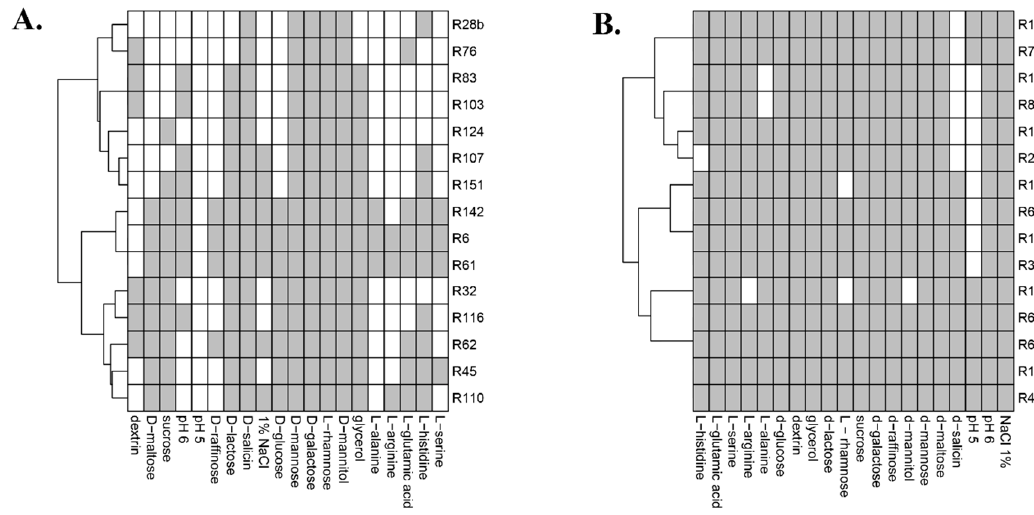
Figure 5. Comparison of results of the GENIII MicroPlate test (A.) and classic phenotypic tests (B.) (grey—growth in selected conditions, white—lack of growth).